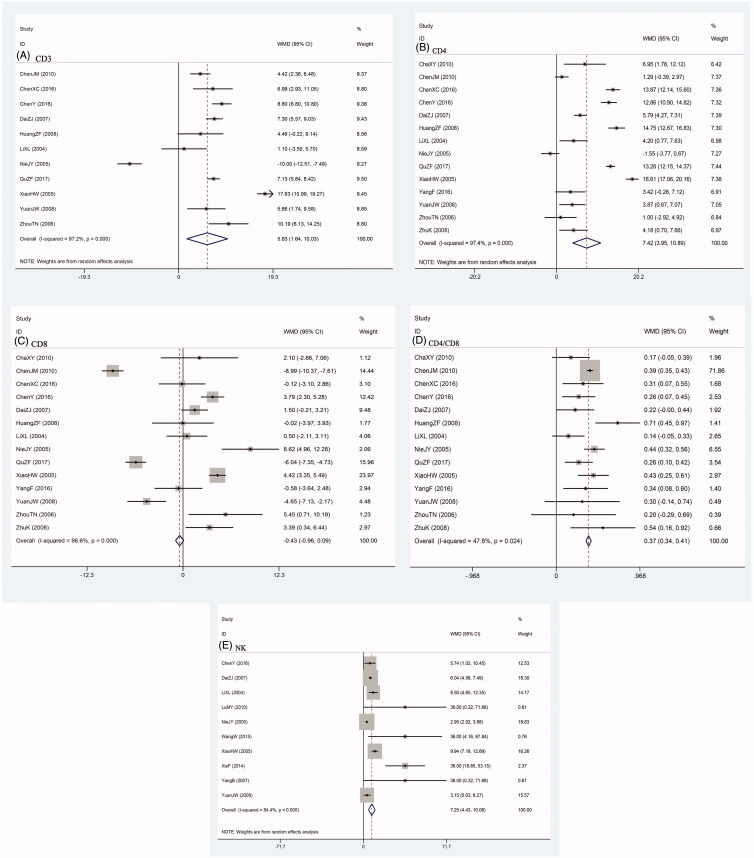
Comparison of immune function between SFI intervention and control group. A: CD3+; B: CD4+; C: CD8+; D: CD4+/CD8+ ratio; E: NK.